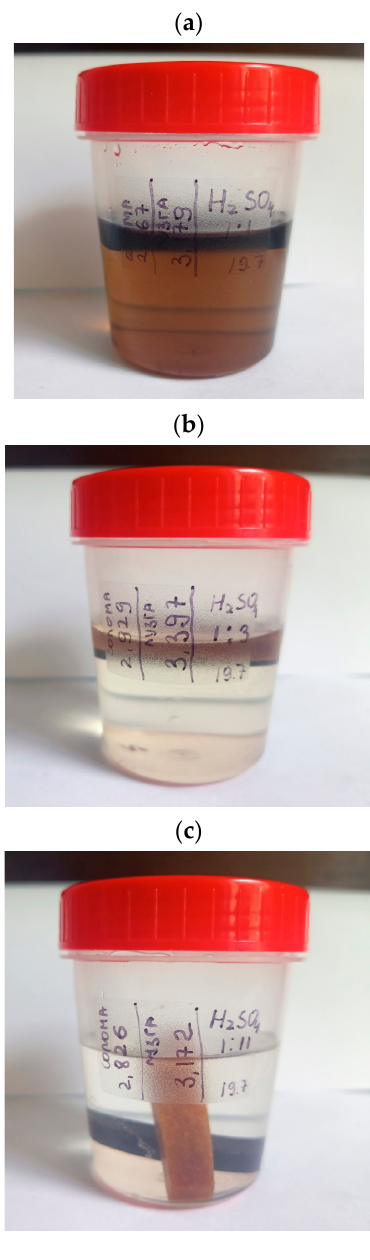
Figure 12 . Photo of polymer composites with wheat straw powder ( fi ller content 30 wt.%) after a Figure 12. Photo of polymer composites with wheat straw powder (filler content 30 wt.%) after a Table 6. Data on weight changes of polymer composites after soaking in